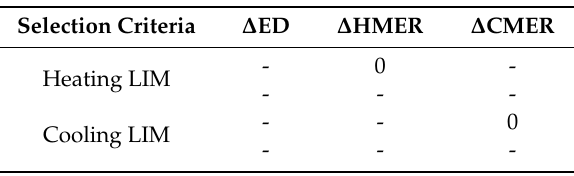
Table 2. Selection criteria for propitious added